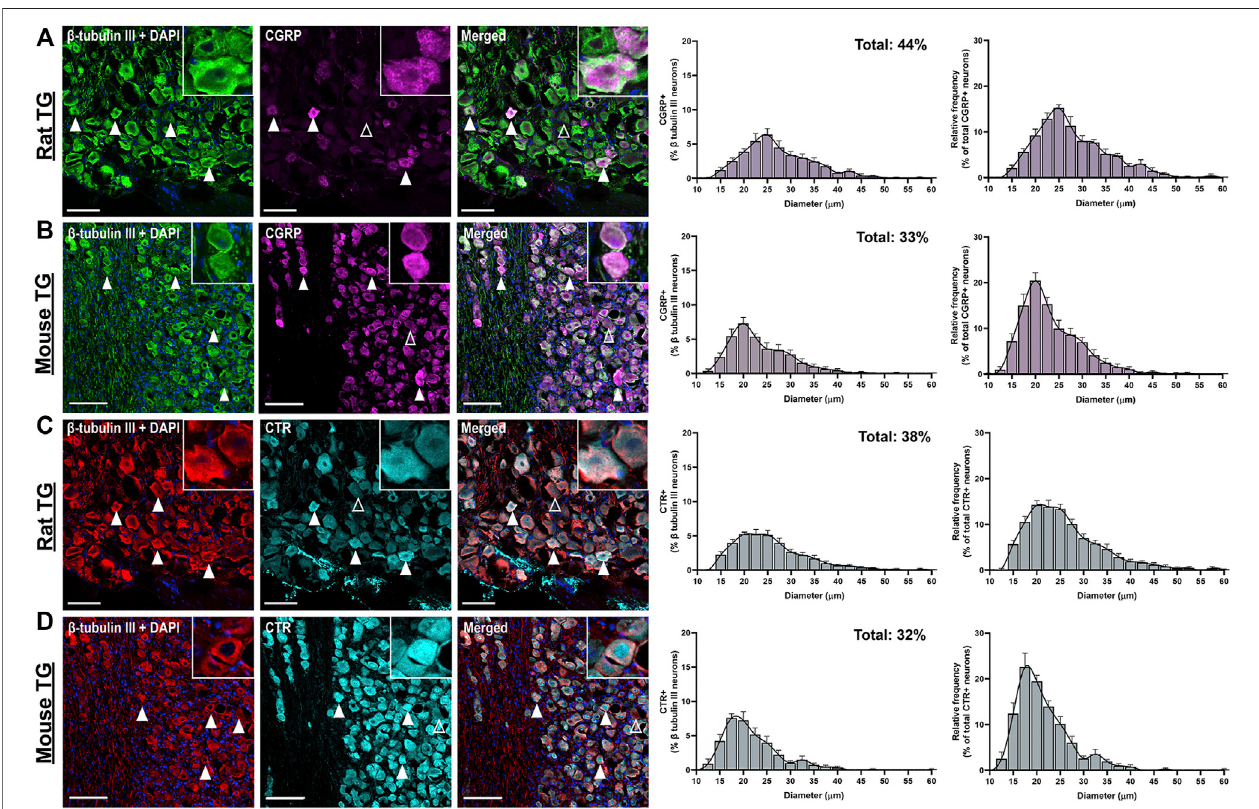
FIGURE 1 | Immunohistochemical localization and quanti fi cation of CGRP (pAb36001, 10 µg/ml) or CTR (pAb188, 10 or 20 µg/ml) individually with β tubulin III (2 µg/ml) in adult rat and mouse TG. (A) CGRP and β tubulin III in rat (B) CGRP and β tubulin III in mouse (C) CTR and β tubulin III in rat and (D) CTR and β tubulin III in mouse. Filled white arrowheads indicate examples of positive staining; empty arrowheads indicate examples of an absence of staining. Image brightness and contrast were adjusted for presentation purposes and merged in FIJI. Scale bar = 100 μ m. Images are representative of six rats and six mice (three male and three female). The size distribution (diameter) of neuronal cell bodies expressing CGRP or CTR for each species are displayed as histograms. The distribution of neuron size was quanti fi ed relative to the total β tubulin III (pan-neuronal marker) expressing neuron population and then relative to either CTR or CGRP expression. Data are the mean ± s.e.m, combined from six individual rats or mice (three male and three